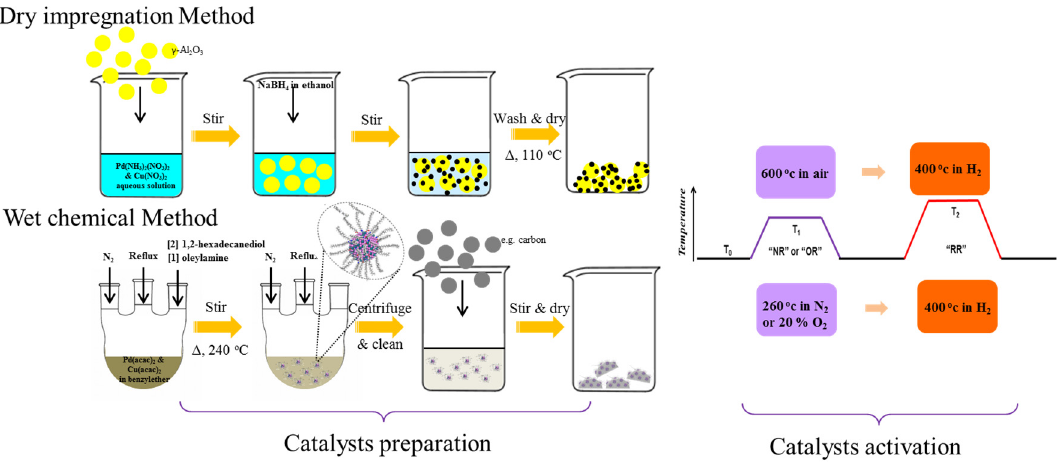
Scheme 1. Illustration of the basic processes in the two methods for the preparation of PdCu alloy nanocatalysts ( left ): dry impregnation method ( top ); and wet chemical method ( bottom ); and